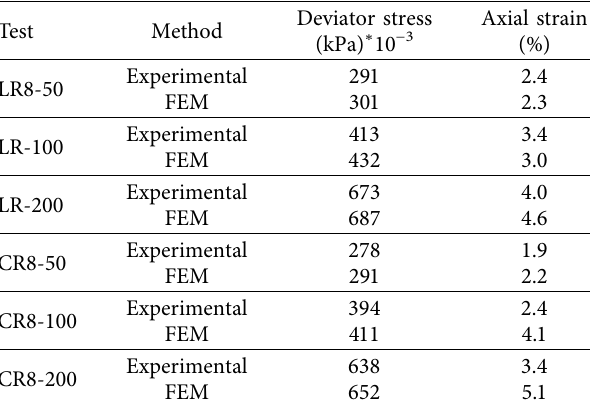
Figure 14: Comparison between deviator stress-lateral strain curves for 8% CRHA and 8% CRHA treated soil (1: 2) after 28 days of curing. Table 5: Comparison of experimental and FEM results at